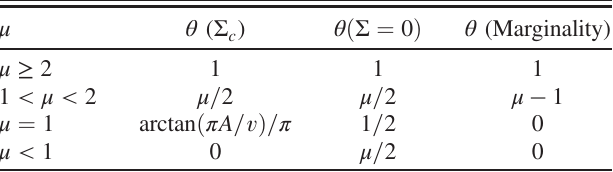
TABLE I. Summary of results: MF values of θ at the yield stress Σ v > 0 ) and after a quench at Σ ¼ 0 (for which c (implying v ¼ 0 ) as a function of the Lévy index μ , the random kick amplitude A , and the bias v . For comparison, we also report θ (marginality) corresponding to the saturation of the stability bound derived in Ref.